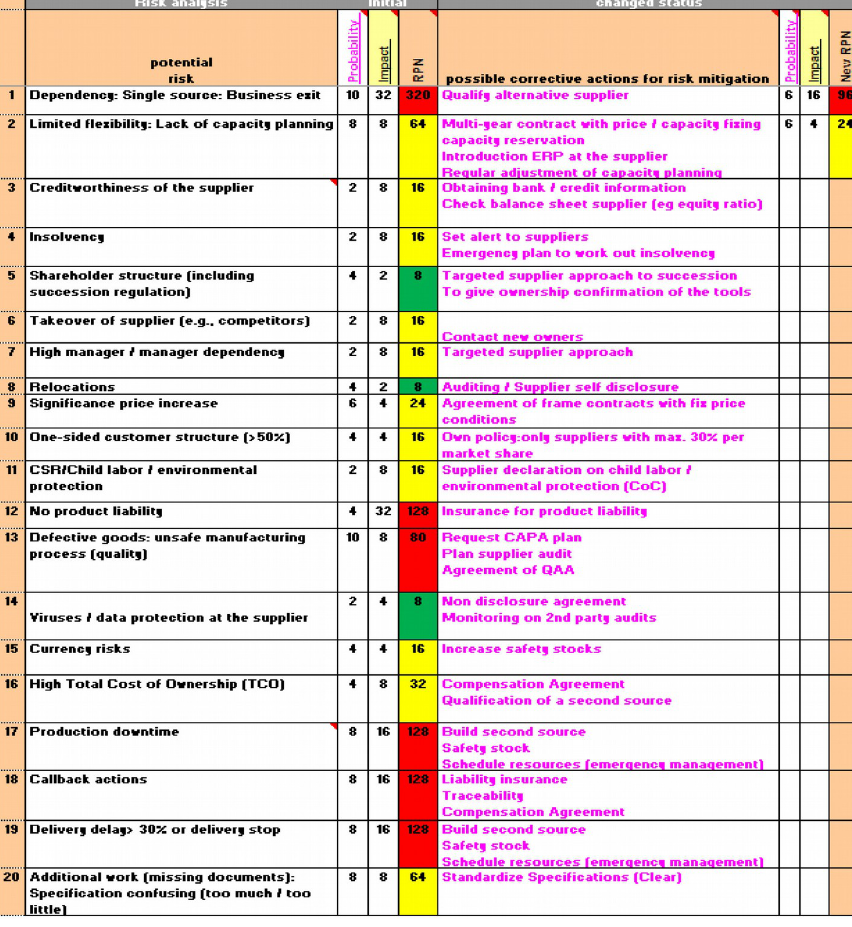
Figure 6. Adapted FMEA. Case